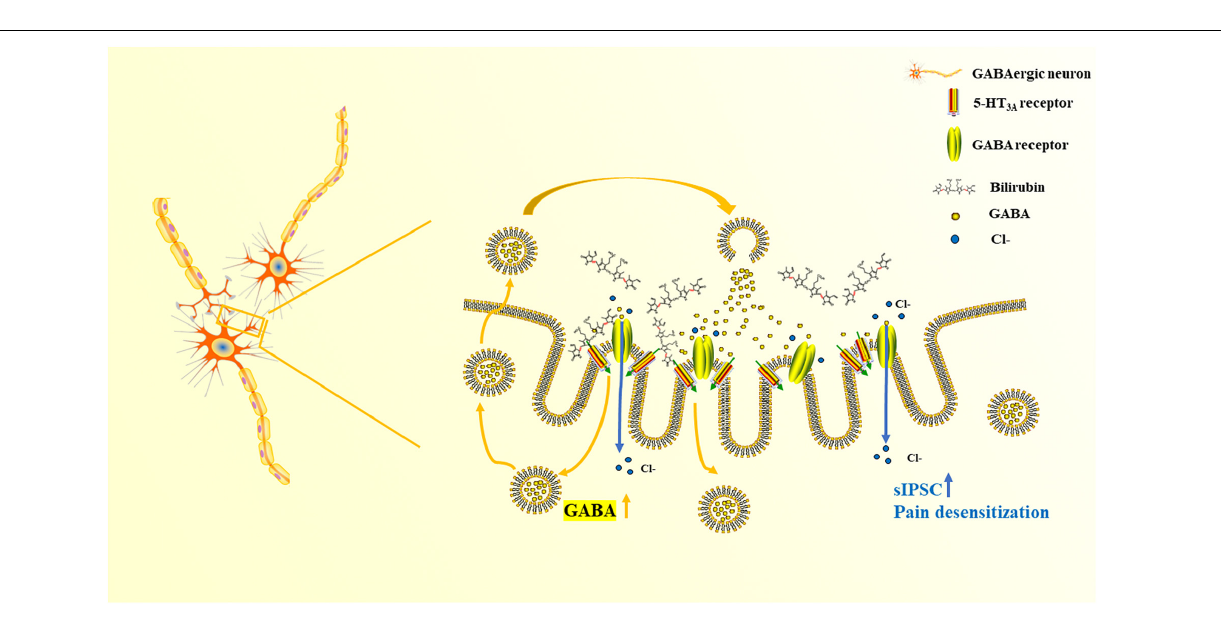
FIGURE 8 | The mechanism map of pain desensitization induced by bilirubin in